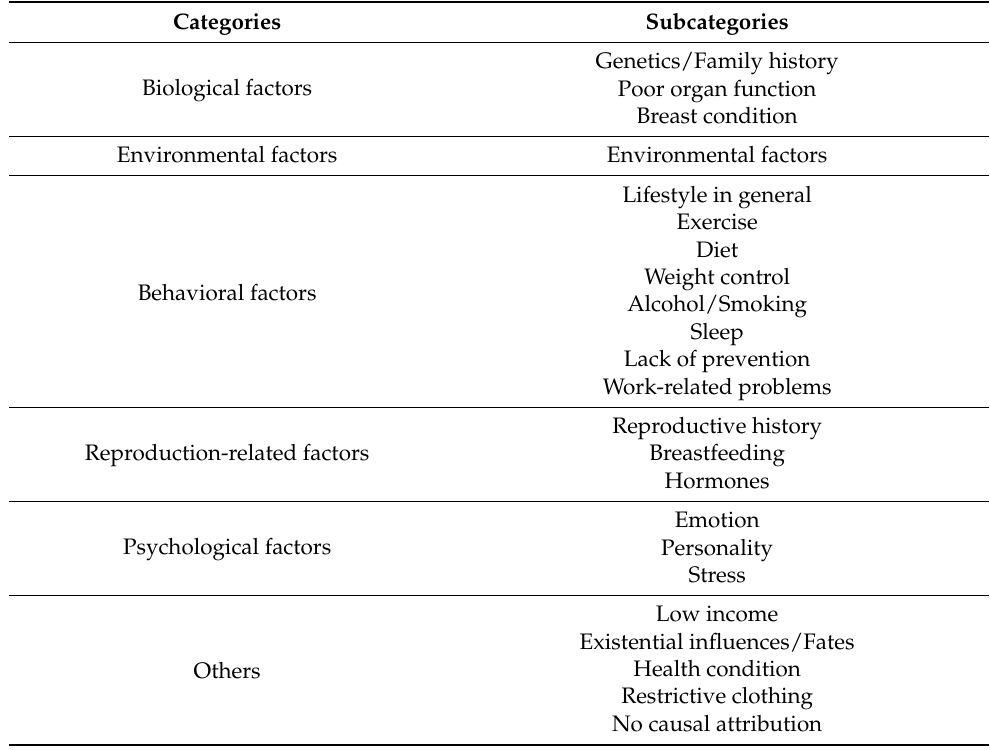
Table 1. Categories and subcategories of causes attributed to breast